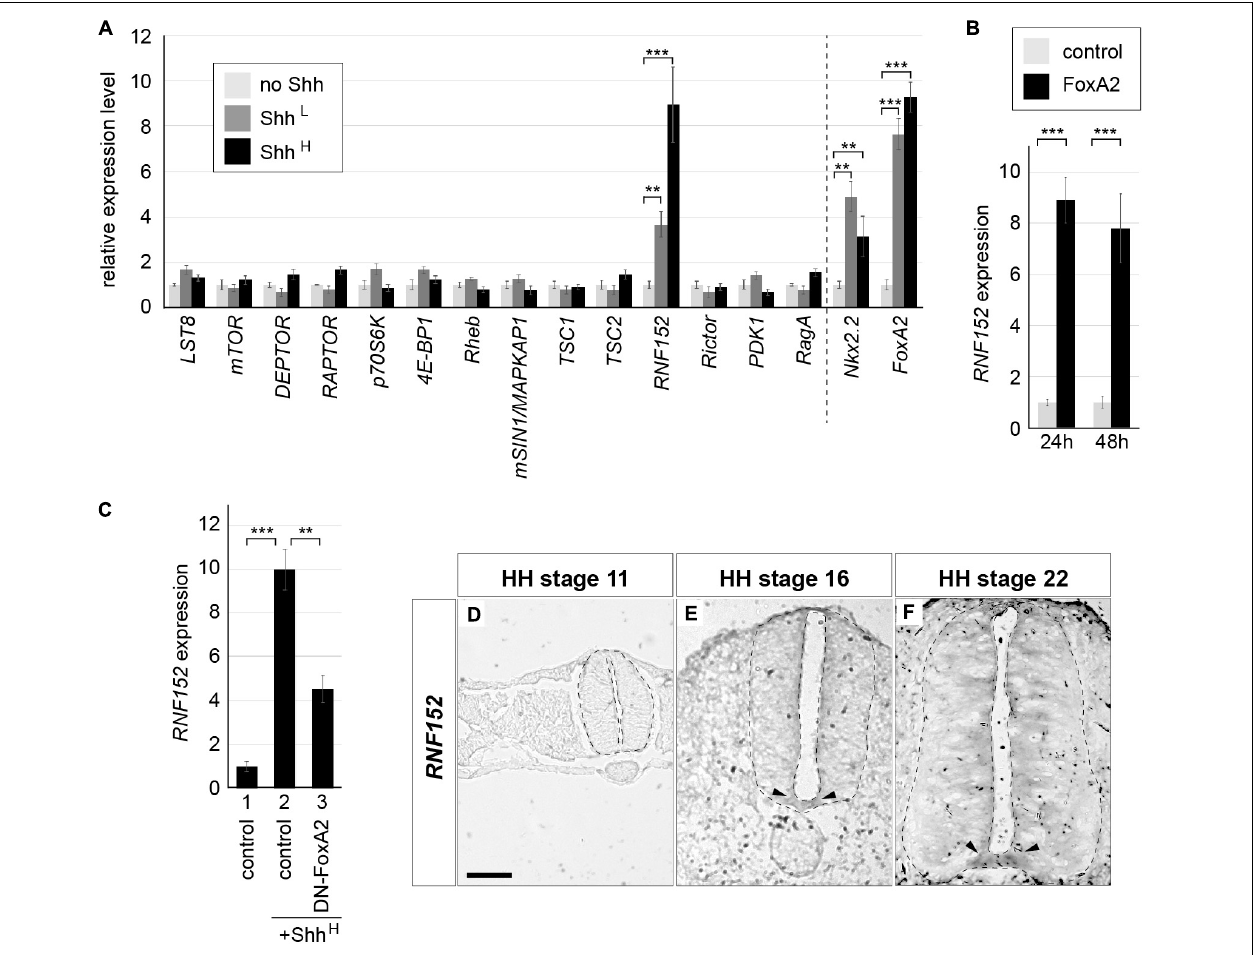
FIGURE 4 | RNF152 is one of target genes of FoxA2, and is expressed in the FP. (A) RNF152 is a responsive gene for Shh. RT-qPCR analysis of genes related to the mTOR signal. Chick neural explants treated with control medium or in the presence of Shh L or Shh H for 48 h were analyzed using the indicated gene primers. (B) RNF152 is a target gene of FoxA2. Explants electroporated with pCIG (control; gray) or pCIG-FoxA2 (black) were cultured for 24 or 48 h and the expression of RNF152 was analyzed by RT-qPCR. (C) FoxA2 is required for the RNF152 expression. Explants electroporated with pCIG (control; lanes 1,2) or pCIG-DN-FoxA2 (lane 3) were treated with control (lane 1) or Shh H -containing medium (lanes 2,3) for 48 h and the expression of RNF152 was analyzed by RT-qPCR. (D–F) RNF152 is expressed in the FP. Sections of the neural tube were analyzed by in situ hybridization with the RNF152 probe at HH stage 11 (D) , 16 (E) , and 22 (F) . The FP expression is indicated by arrowheads (E,F) . Scale bar = 50 µ m. ∗∗ p < 0.01, ∗∗∗ p <